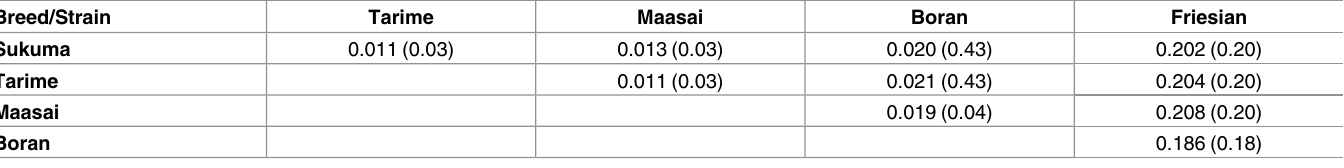
Table 2. Differentiation (F ST ) between Tanzanian cattle breeds/strains.